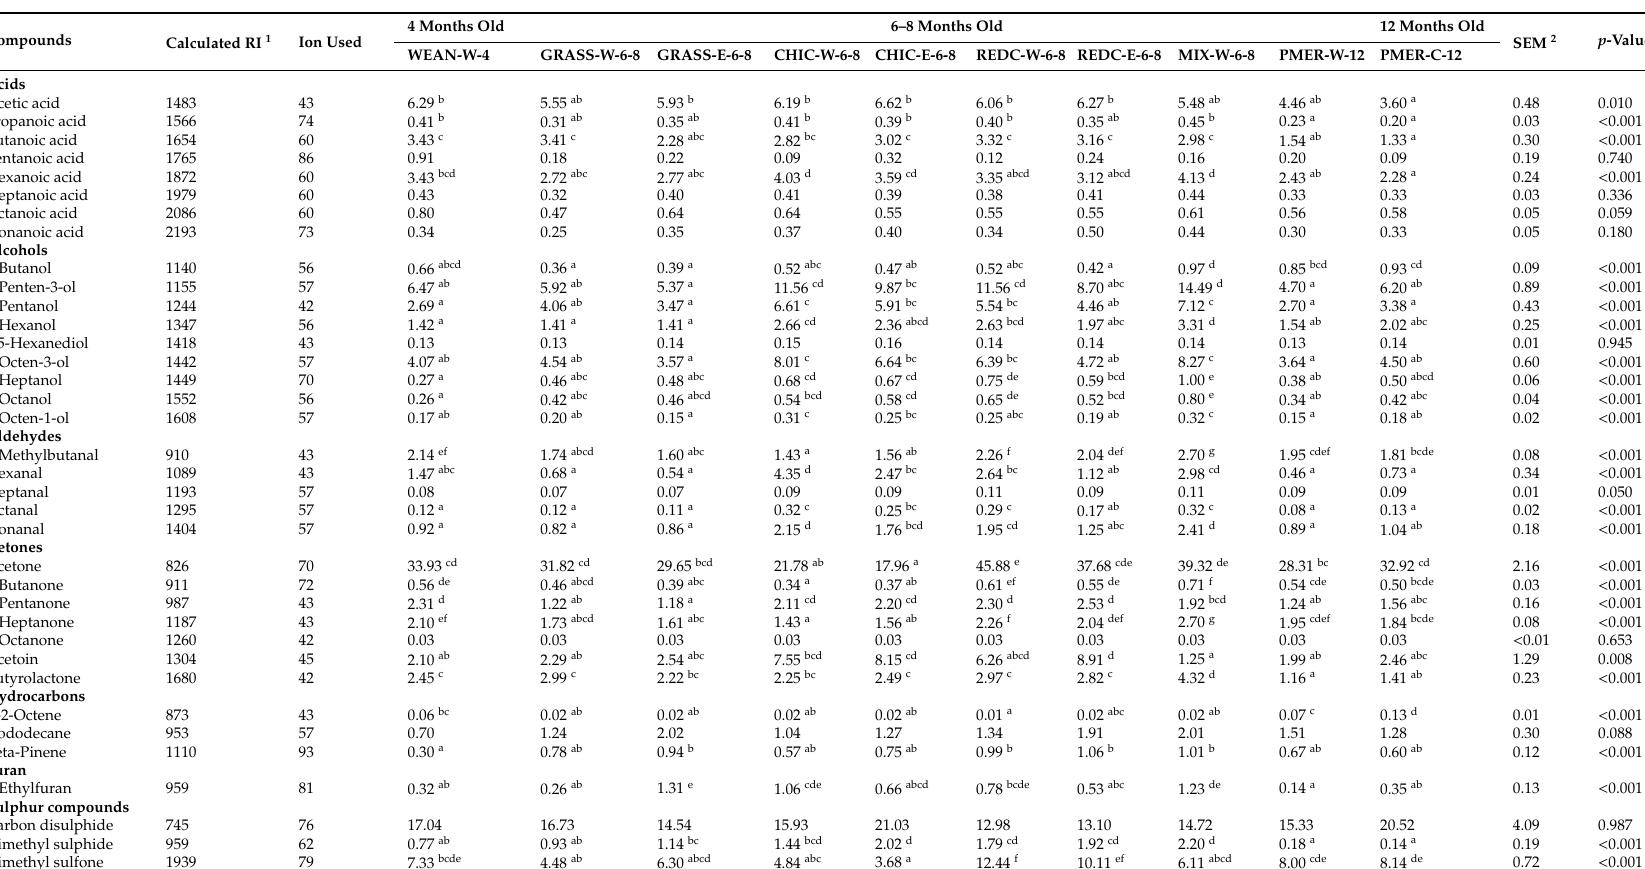
Table 5. Volatile compounds in the headspace of raw lamb loin from animals finished on di ff erent forage systems. The values for di ff erent volatile compounds correspond to the peak area of the selected mass ion (ion used) divided by the peak area of the internal standard ion ( m / z 81 ).